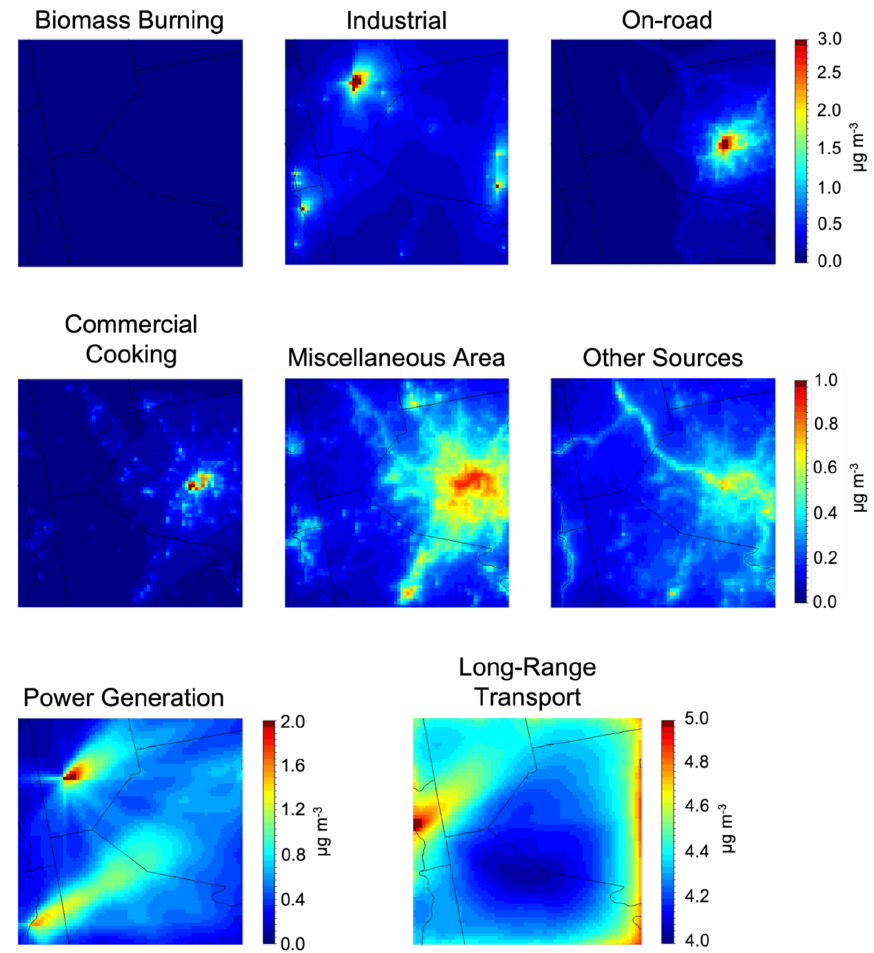
Figure 8. Contribution of each source to total PM 2 . 5 during July 2017. Different scales are used for the various maps.